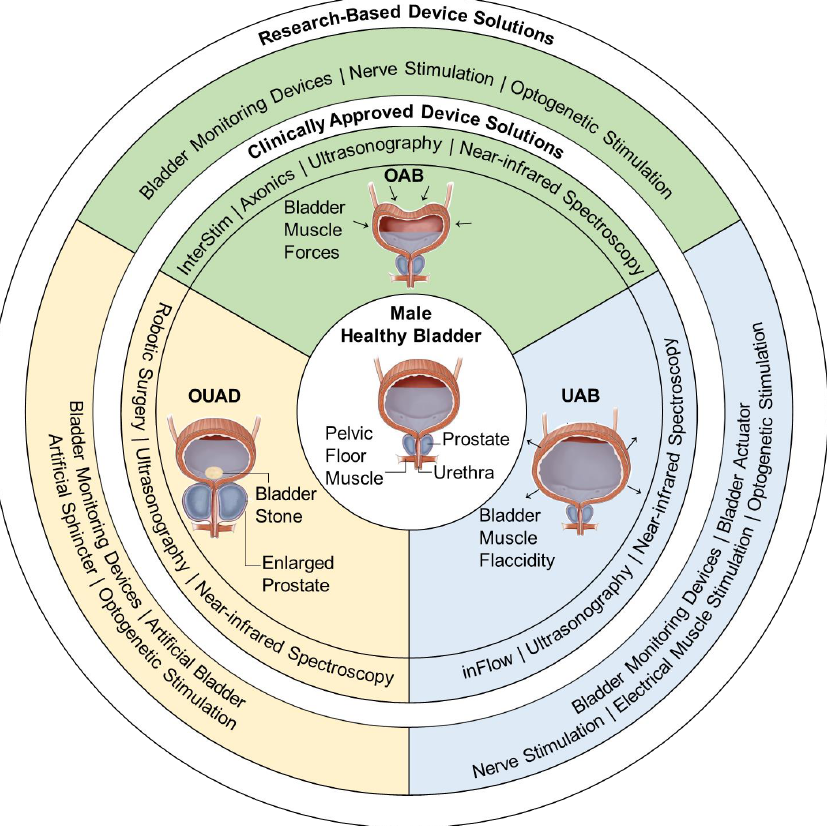
Figure 1. Clinically approved and research-based electronic device solutions for overactive bladder (OAB), underactive bladder (UAB) and other-urinary-affecting disorders (OUAD). Clinically ap- proved electronic solutions include InterStim [40], Axonics modulation technologies [53], inFlow [39], robotic surgery [54,55], ultrasonography systems [56,57] and near-infrared spectroscopy [58]. Research-based device solutions include bladder-monitoring devices [59 – 64] , nerve stimulation [46], optogenetic stimulation [43 – 45], electrical muscle stimulation [65,66], bladder actuators [47 – 49], artificial sphincter [67,68], and artificial bladder [50 – 52].